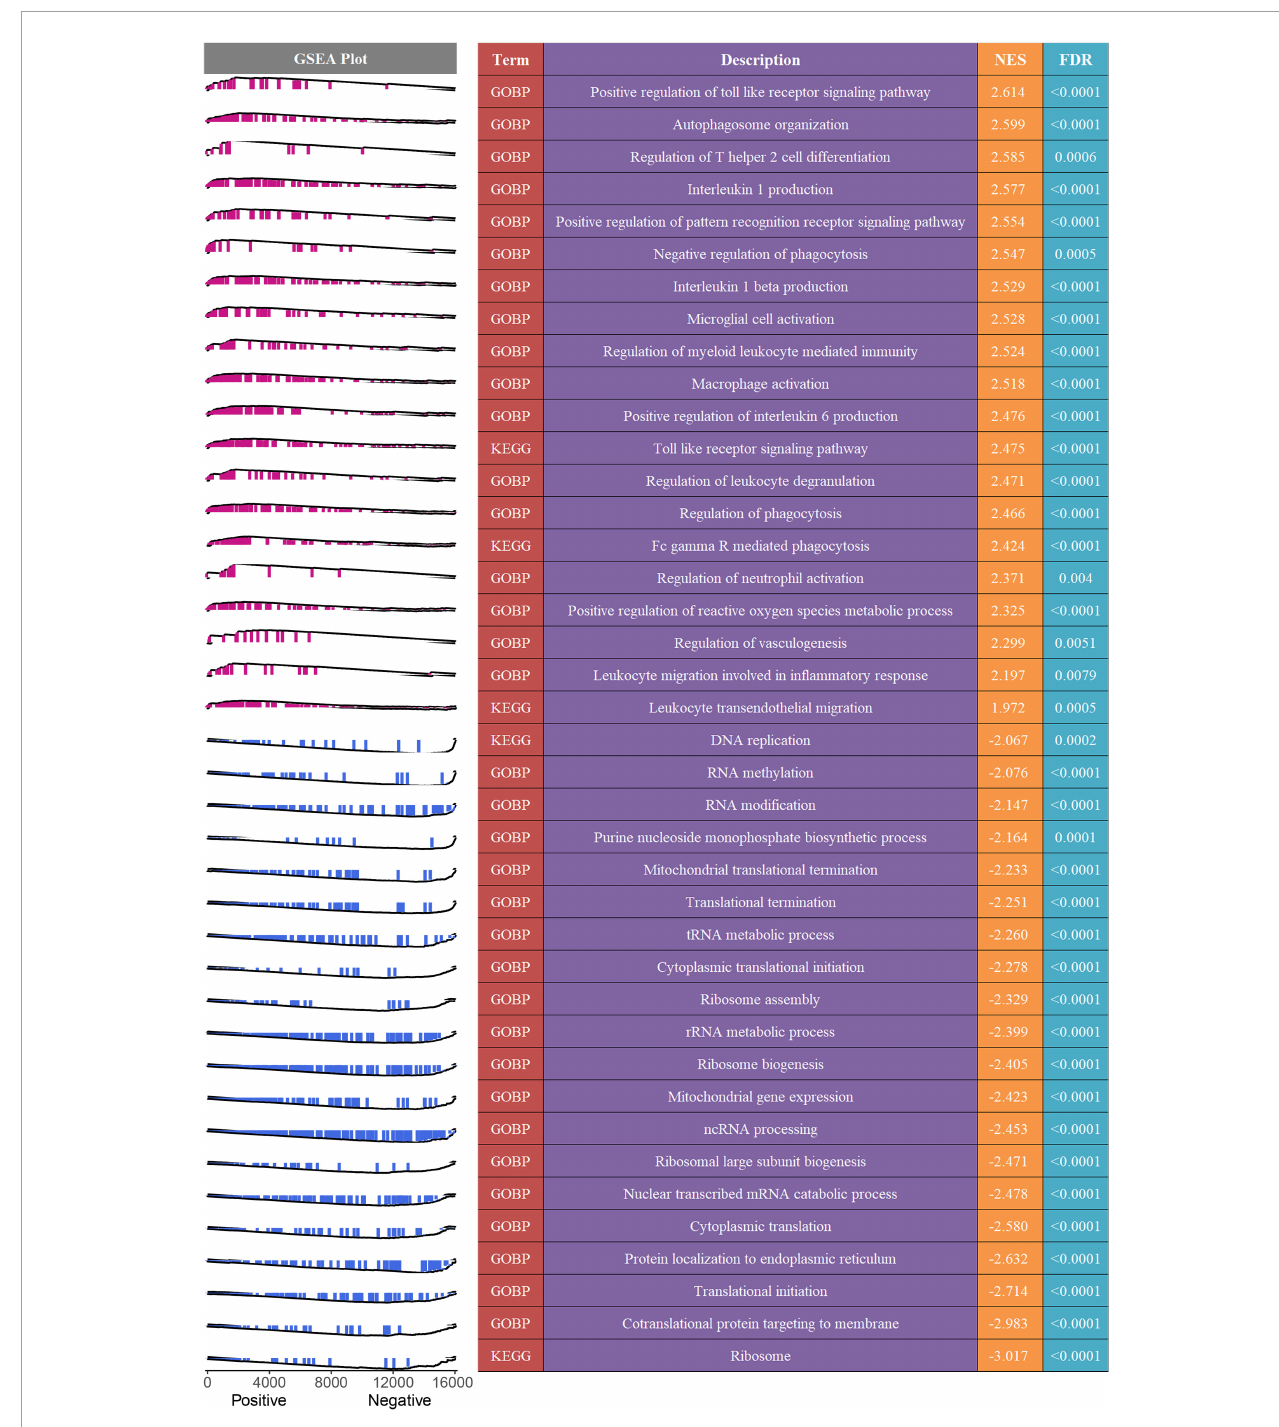
FIGURE7 Potential biological mechanisms underlying the MLDGS. The right panel presented some important biological pathways that were significantly enriched (FDR < 0.01) in GSEA. NES > 0 and NES < 0 suggested pathway activation and inhibition, respectively. NES, normalized enrichment score. The left panel displayed a brief gene set enrichment map of these specific pathways and their relationship to the MLDGS. Purple and blue represented positive and negative correlation between pathway and MLDGS,